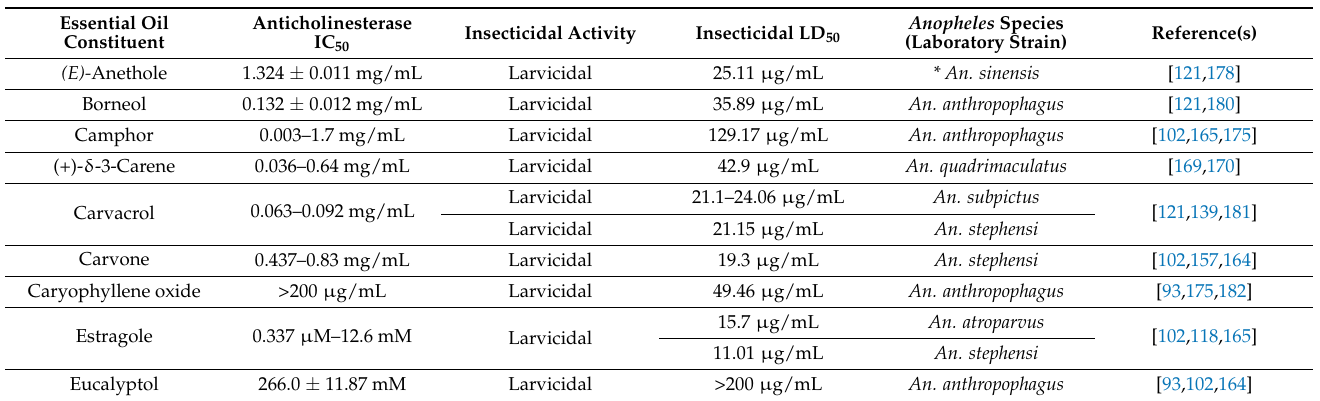
Table 3. Anticholinesterase and insecticidal activities of